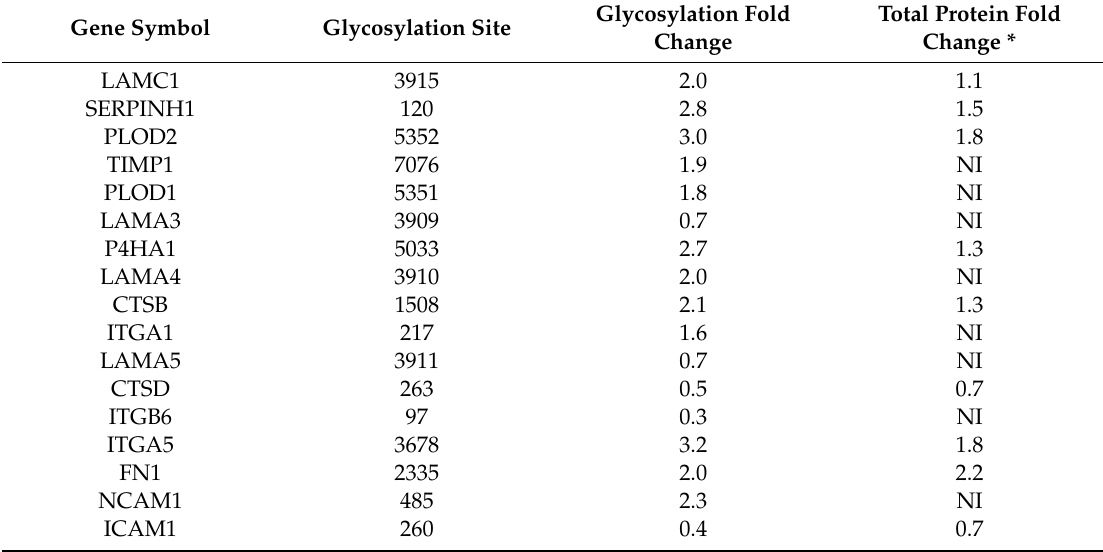
Table 1. N-linked glycosylation levels and their corresponding expression of proteins involved in extracellular matrix organization